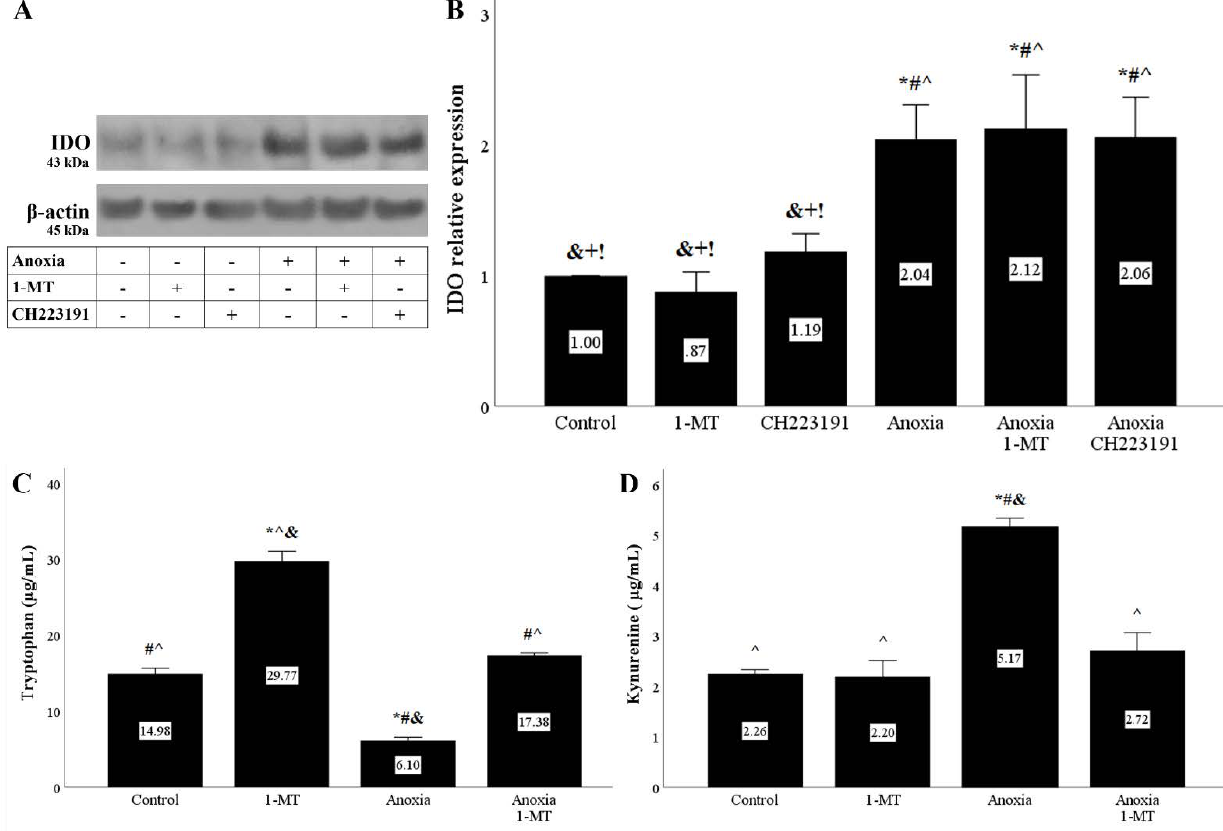
Figure 1. Anoxia upregulates IDO expression and activity. Cells were cultured under anoxic conditions for 24 h along with the indicating treatments. Anoxia in the presence or not of 1MT or CH223191 increased IDO protein level. A repre- sentative Western blot experiment is displayed in panel ( A ), whereas panel ( B ) depicts the cumulative results of four repeated experiments. * p < 0.05 vs. Control, # p < 0.05 vs. Control with 1-MT, ^ p < 0.05 vs. Control with CH223191, & p < 0.05 vs. Anoxia, + p < 0.05 vs. Anoxia with 1-MT, ! p < 0.05 vs. Anoxia with CH223191. IDO activity assessed by the ratio of kynurenine to tryptophan concentration in cell culture supernatants also increased under anoxic conditions, an effect that is abolished by the IDO inhibitor 1-MT ( C – E ). Six such experiments were performed. * p < 0.05 vs. Control, # p < 0.05 vs. Control with 1-MT, ^ p < 0.05 vs. Anoxia, & p < 0.05 vs. Anoxia with 1-MT. Error bars correspond to SEM. 1-MT, 1-DL- methyltryptophan; IDO, indoleamine 2,3-dioxygenase 1.